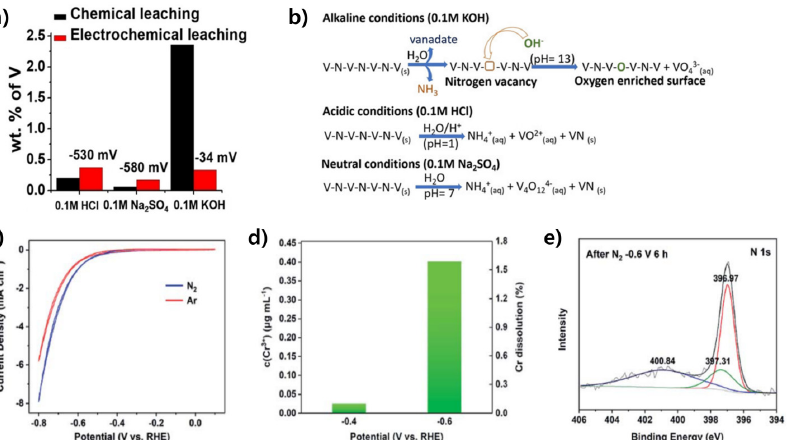
Figure 6. ( a ) Comparison of leached vanadium in VN after chemical and electrochemical reactions in acidic, neutral, and alkaline media. ( b ) The proposed NH 3 production mechanism of VN in each condition. ( c ) CV curves of CrN NPs under N 2 - and Ar-saturated solutions. ( d ) Cr 3+ concentration and dissolution ratio at − 0.4 V and − 0.6 V for 1 h electrolysis. ( e ) XPS N-1s spectra after electrolysis for 6 h at − 0.6 V. Reproduced with permission from Wiley [85] and the Royal Society of Chemistry [87].